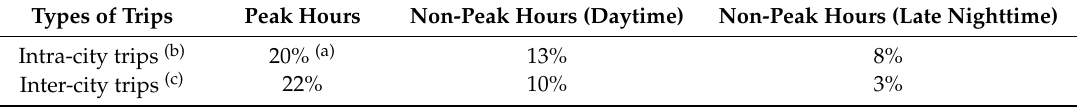
Table 2. Spatiotemporal variations in traffic congestion in the study area (Source: